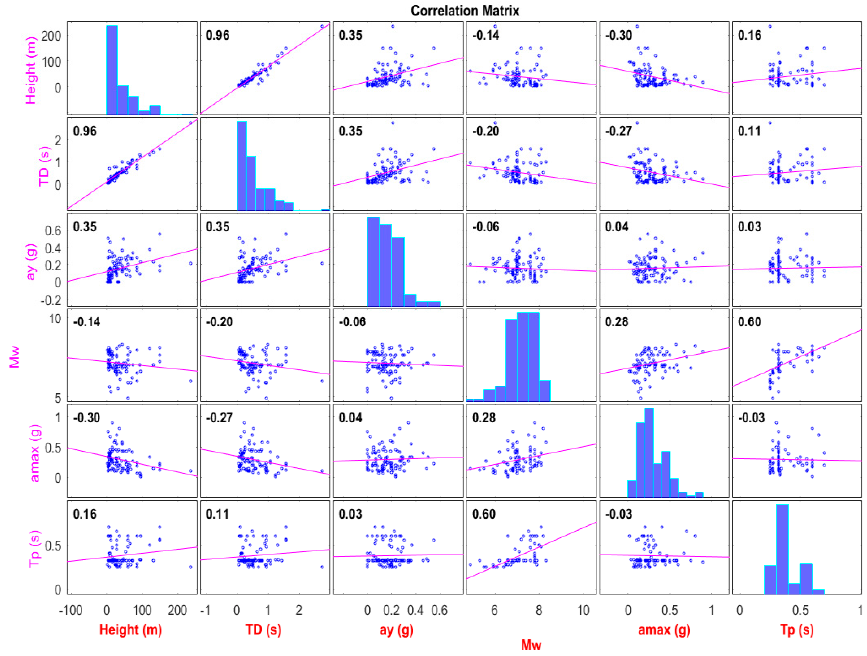
Figure 1. Di ff erent distribution of the used parameters. Figure 1. Different distribution of the used parameters.